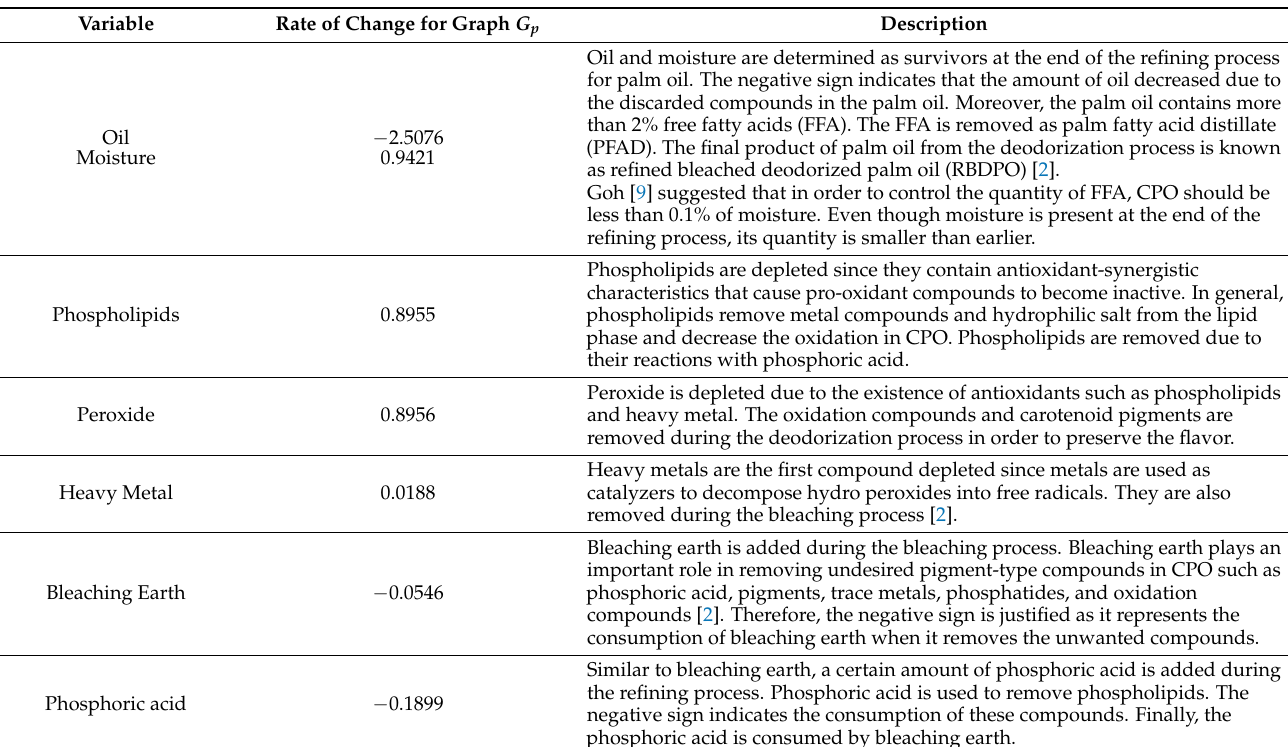
Table 8. Analysis of graph G P